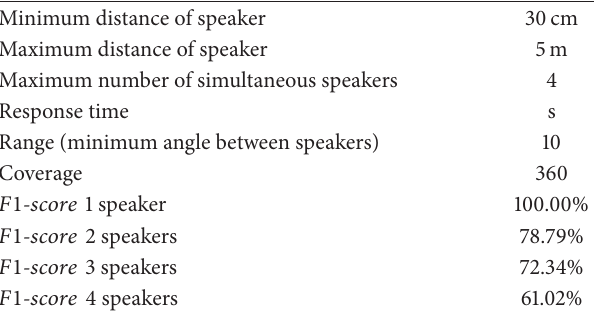
Figure 4: Microphones of the audio localization system in the robot Golem-II+. Table 3: Multiple-DOA estimation system performance.